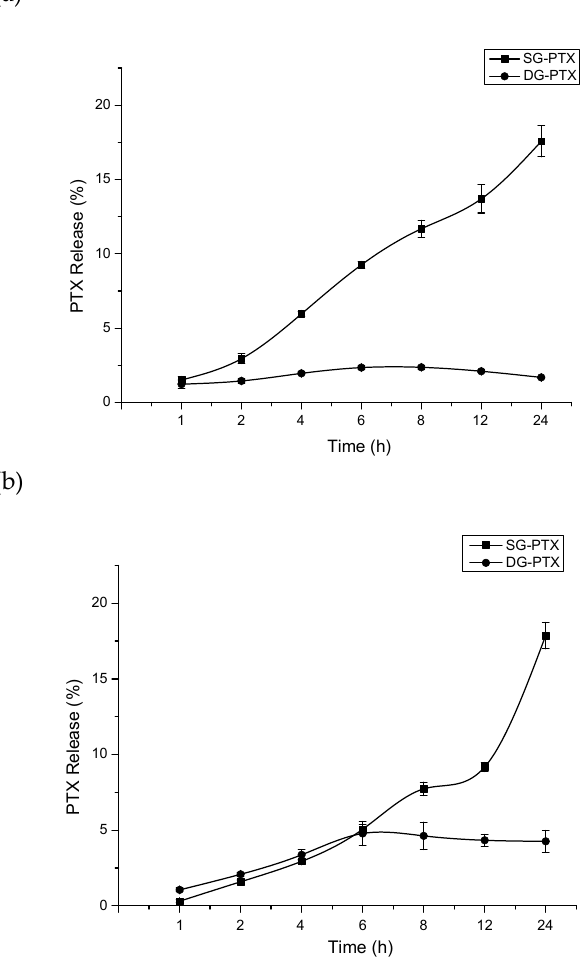
Figure 3. Free PTX released from the prodrugs in serum. ( a ) PTX released from SG-PTX and DG-PTX in FBS, ( b ) PTX released from SG-PTX and DG-PTX in RS. All values are expressed as mean ± SD (n = 5). “FBS” stands for fetal bovine serum and “RS” for rabbit serum.